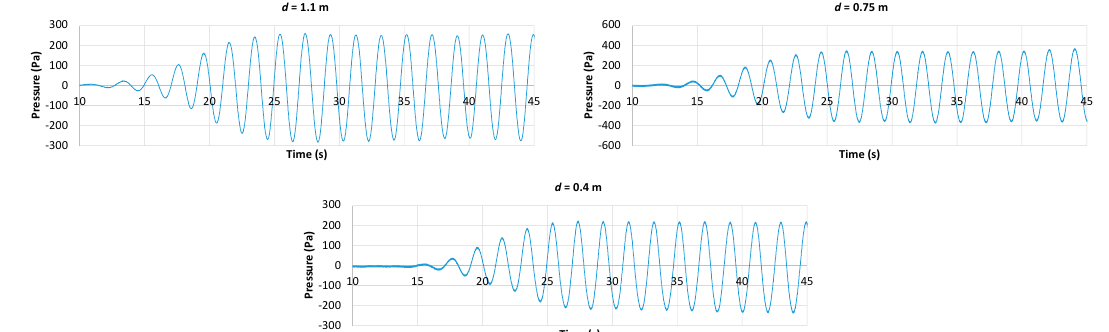
Figure 5. Measured pressure on three water depths with T = 1.95 s and A = 50.5 mm.